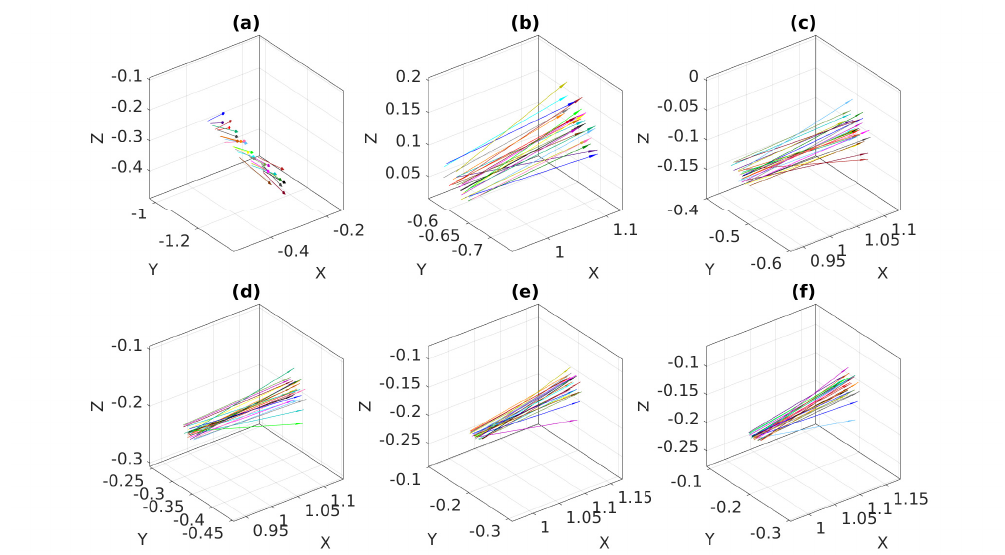
Figure 16. Optimization process of the proposed method with feature noise [0–1.5 pixel]: ( a ) Normal vectors at iteration 1; ( b ) Normal vectors at iteration 4; ( c ) Normal vectors at iteration 6; ( d ) Normal vectors at iteration 8; ( e ) Normal vectors at iteration 12; ( f ) Normal vectors at iteration 16 (converged).